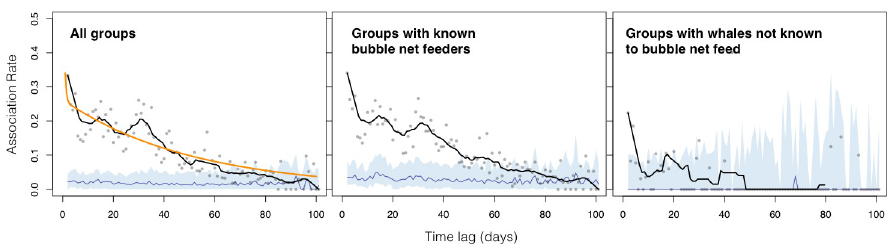
Fig 4. Lagged Association Rate (LAR) of humpback whales in the Kitimat Fjord System, parsed into three subsets of our data: All groups encountered ( left ), groups containing known bubble net feeders ( center ), and groups containing whales not known to bubble net feed ( right ). Grey dots represent the Association Rate calculated for each time lag (in days) tested. Black line is the running mean of LIR (window = 10 days, first point forced to the τ = 1, last point forced to the final τ ). Blue line and shaded area represent the median and 95% confidence interval (2.5% and 97.5% quantiles), respectively, of the randomized null model (n = 100). Lags at which the running mean rises above the shaded area indicate significantly stable dyadic associations. The orange line on the left plot (‘All groups’) represents the best-fitting SOCPROG model of LAR (see S7 Table in S1 File).